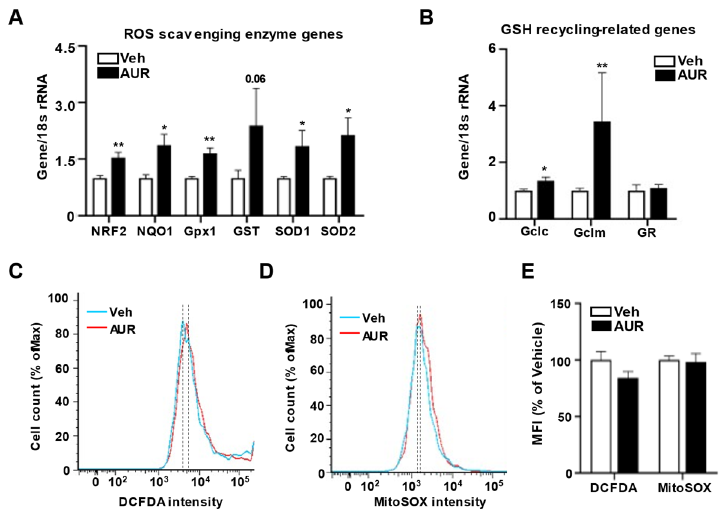
Figure 2. Increase of genes encoding antioxidant enzymes in bEnd.3 cells by AUR treatment. ( A , B ) mRNA expressions for ROS scavenging antioxidant enzymes and GSH recycling-related genes were analyzed using qPCR with bEnd.3 cells treated with vehicle or 1 µM AUR. ( C , D ) bEnd.3 cells were incubated with vehicle or 1 µM AUR. The cells were stained with 5 µM CM-H 2 DCFDA or 5 µM MitoSOX TM and analyzed by flow cytometry. Total ROS was determined by DCFDA-stained cells ( C ) and mitochondrial ROS was determined by MitoSOX TM —Stained cells ( D ). Median fluorescence intensity (MFI) values are analyzed by FlowJo program. Data are presented as mean and ± SEM of three independent experiments (* p < 0.05, ** p < 0.01, *** p < 0.001 compared to Veh).